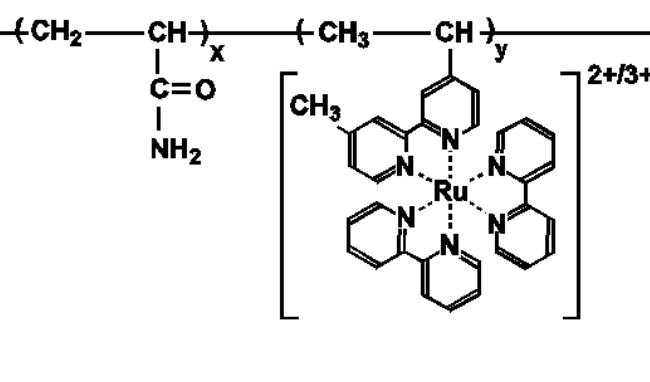
Figure 3. Chemical structure of poly(AM- co -Ru(bpy)